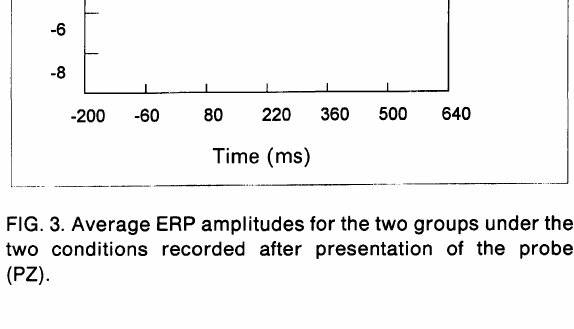
A MANOV A with repeated measures on list posi tion and averaged tests of significance (Group x